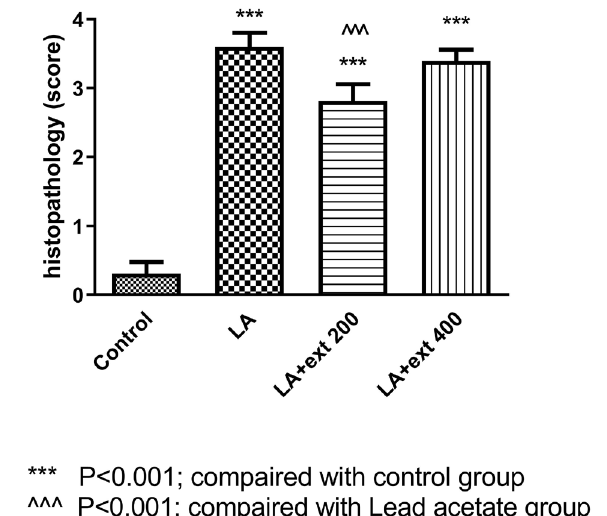
FIGURE 6 - Effect of Rheum ribes extract (ext) on liver tissue in rats treated with lead acetate